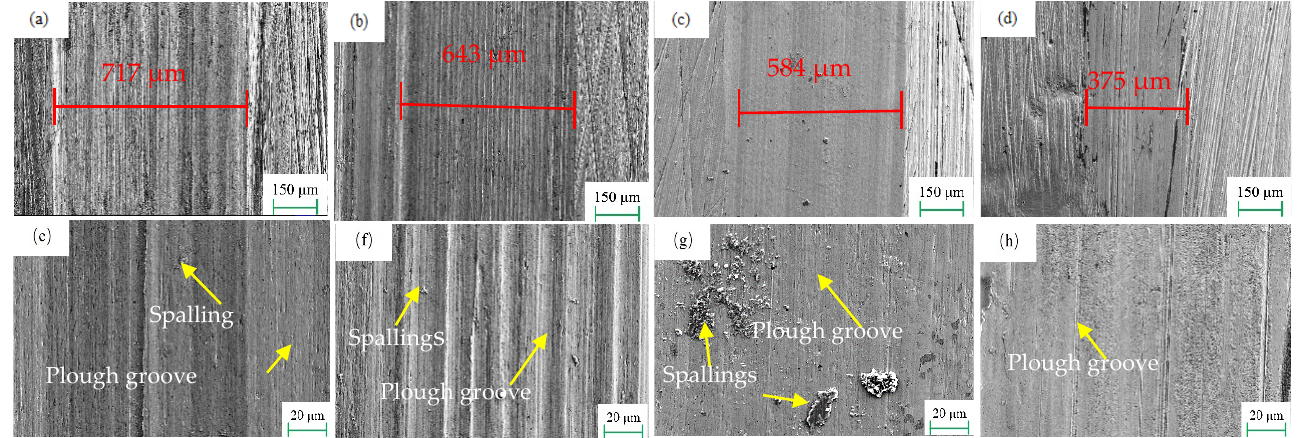
Figure 12. Morphology of wear track of ( a , e ) CoCrNi, ( b , f ) CoCrNiMo 1 , ( c , g ) CoCrNiMo 3 and ( d , h ) CoCrNiMo 5 .